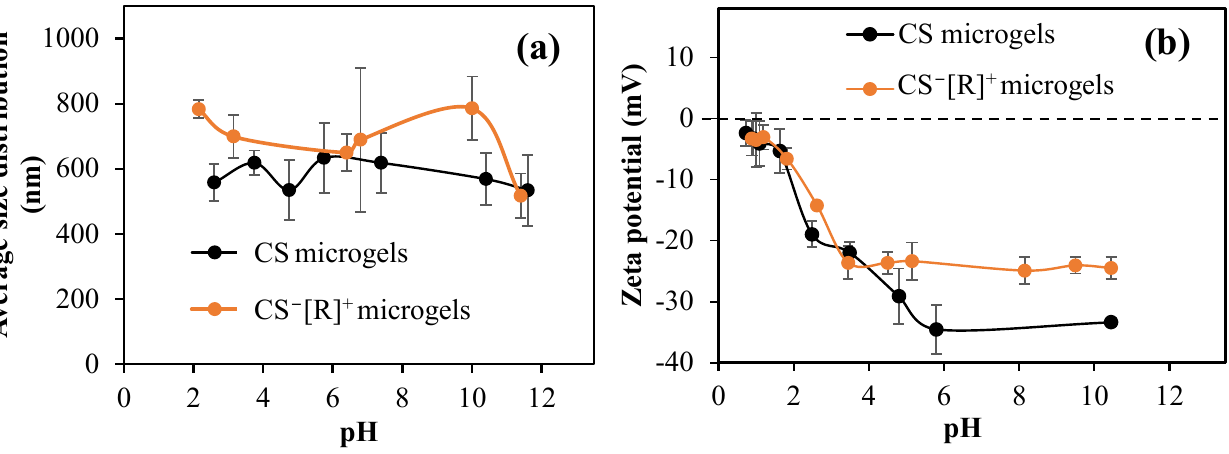
Figure 3. ( a ) Sizes of CS microgels and CS − [R] + microgels at different pH values; ( b ) pH versus zeta potential graphics of CS microgels and CS − [R] + microgels in pH 1–10 range. The zeta potentials of CS microgels and CS - [R] + microgels in 1 mM KNO 3 versus pH were measured. As presented in Figure 3b, the isoelectric point could not be detected in both microgels. The pH value measured in the 1 mM KNO 3 solution for the CS microgel was 10.45, and the zeta potential at that pH value was − 33.4 ± 0.7 mV. For the CS - [R] + microgels, the measured pH was 8.5, and its zeta potential was − 24.5 ± 2.1 mV. To ensure the safety of the biomaterials, a biocompatibility test, e.g., the effects of materials on the viability of healthy cells, such as L929 fibroblasts, needed to be studied. Therefore, the cytotoxicity levels of CS microgels and polyelectrolyte CS − [R] + microgels at different concentrations ranging from 50 to 1000 μ g/mL were determined on L929 fibro- blast cells for a 24 h incubation time, and the corresponding results are demonstrated in Figure 4a.